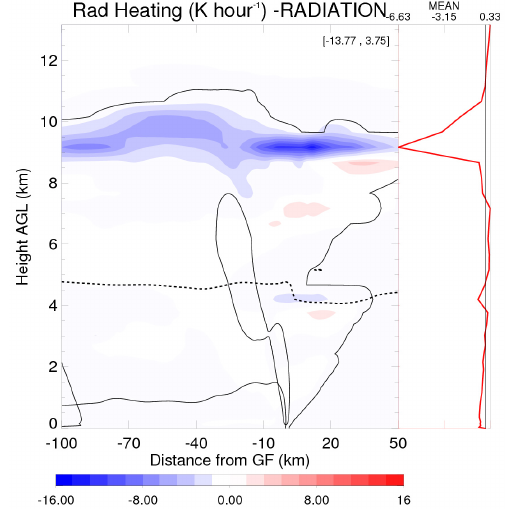
Fig. 11. Same as Fig. 10, except for radiative heating rate (Kh − 1 ) and only shown for RADIATION and dOffrOn.